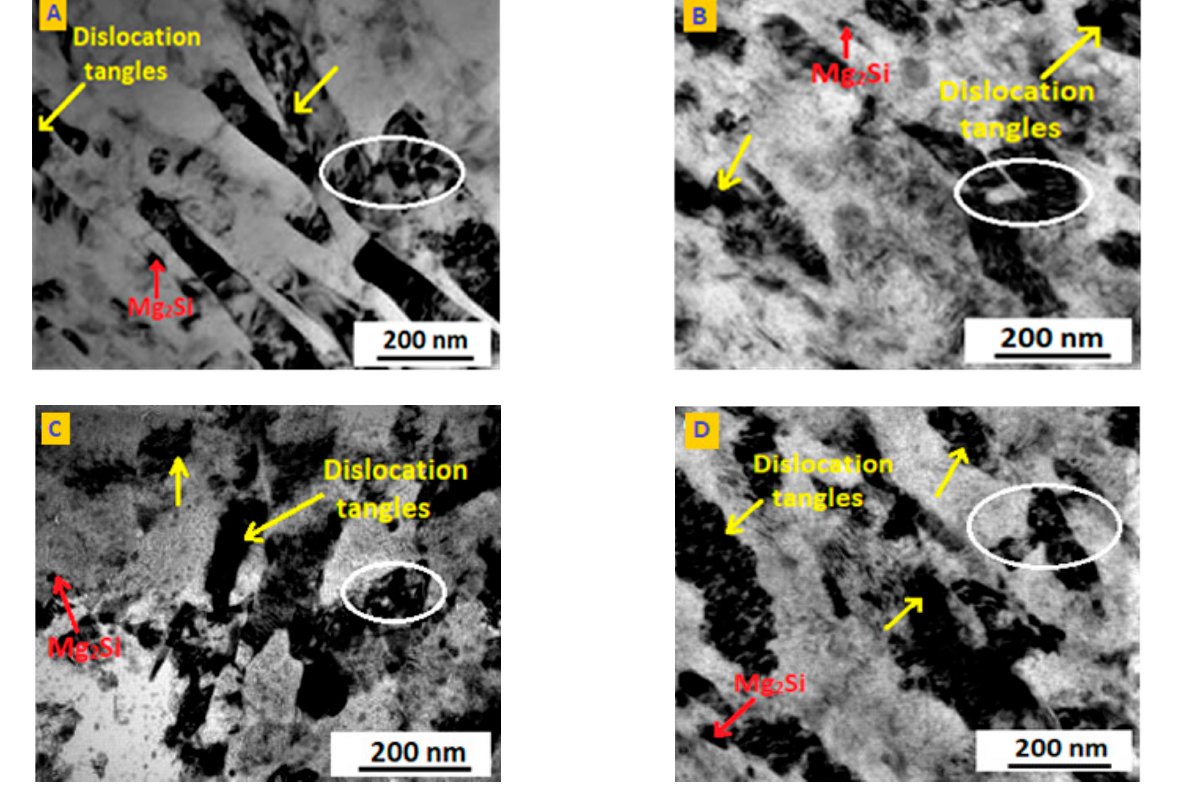
Figure 6. TEM images of Al5083 alloy in ( A ) as-received condition and after the ( B ) 1st pass, ( C ) 2nd pass, and ( D ) 3rd pass.